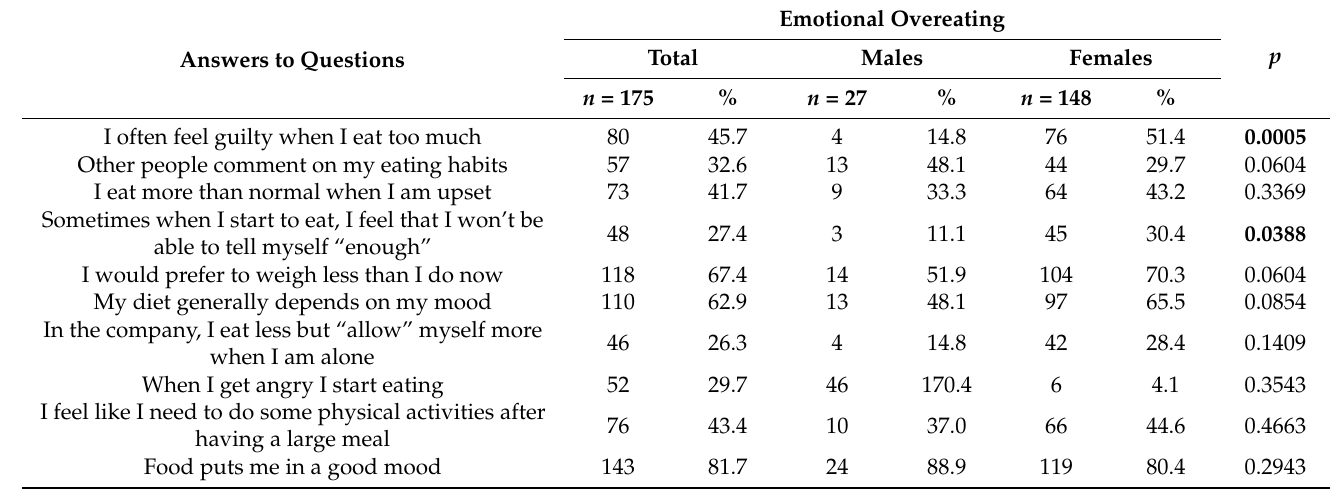
Table 6. Answers to questions on emotional overeating in males and females.